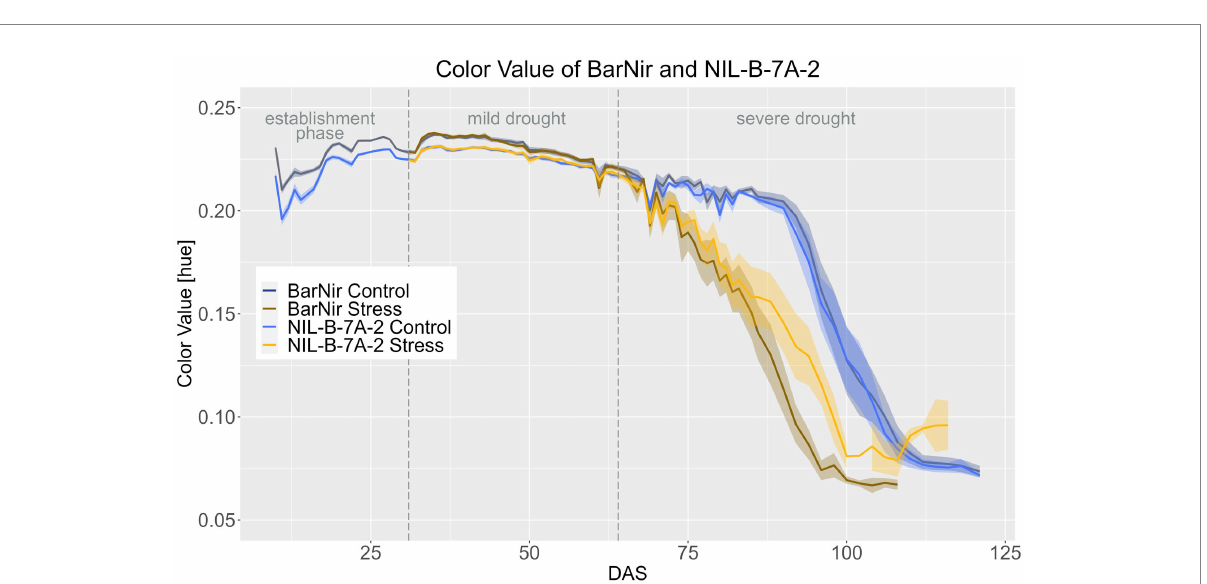
FIGURE 5 Color value of BarNir and NIL-B-7A-2 based on the calculated BLUEs values. DAS, days after sowing; BBCH55, heading day. The last DAS for each genotype was chosen for the DAS where the last time 60% of the plants were imaged (as mature plants were taken off subsequently). The shadows describe the confidence interval; as long as the shadows of the individual lines do not overlap, the significance level of a = 0.05 is not reached and therefore a significant difference